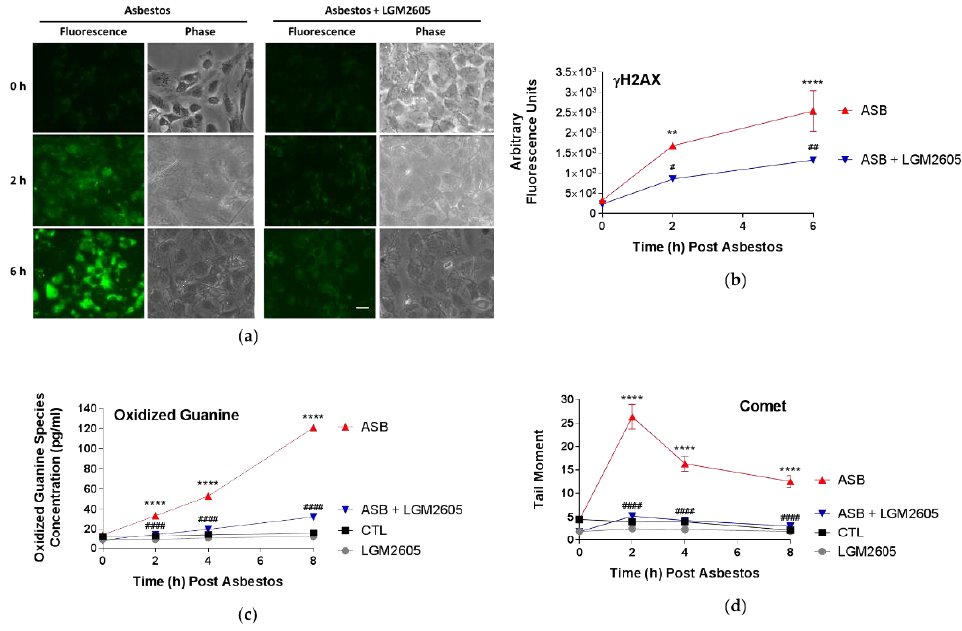
Figure 7. Asbestos-Induced DNA Damage is Ameliorated by LGM2605 Treatment. Human pleural mesothelial cells were plated in a 6-well plate (1 × 10 6 cells/well) and exposed to 50 µM LGM2605 4 h prior to exposure to sterile crocidolite asbestos fibers (20 µg/cm 2 ). Asbestos-induced DNA damage was determined by evaluation of γ H2AX, a marker of DNA double-strand breaks, immunostaining ( a ) followed by quantification of the total fluorescence intensity of a particular field (scale bar = 15 µ m) ( b ). Additionally, the release of oxidized guanine species ( c ) and the evaluation of DNA single-strand breaks by comet assay ( d ) were determined at 0, 2, 4, and 8 h post asbestos exposure. Samples were run undiluted in triplicate and γH2AX quantification, the release of oxidized guanine species (pg/mL), and tail moment are presented as mean ± SEM. * indicates a statistically significant difference ( p < 0.05) between ASB and CTL treated cells (** p < 0.01, **** p < 0.0001). # indicates a statistically significant difference ( p < 0.05) between ASB and ASB + LGM2605 treated cells (# p < 0.05, ## p < 0.01, #### p < 0.0001).